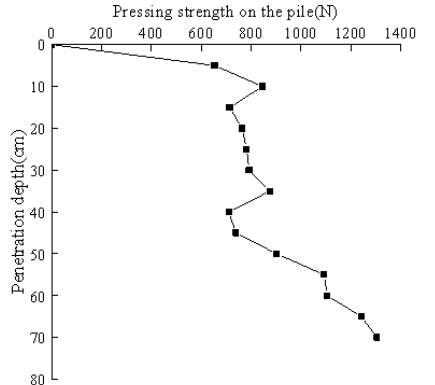
Figure 9. The relationship between the pile driving pressure and the penetration depth at different pile pressing depths.